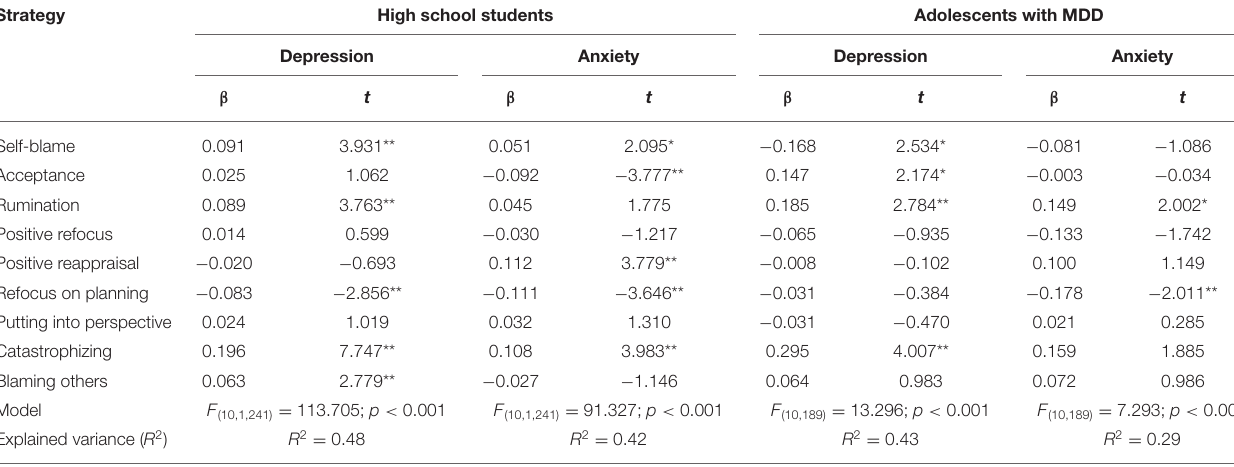
TABLE 4 | MRA on symptoms of depression and anxiety for high school students and adolescents with MDD. Strategy High school students Adolescents with MDD Depression Anxiety Depression Anxiety